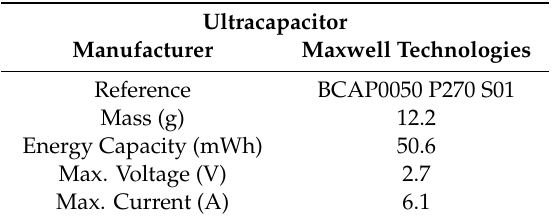
Table 2. Characteristics of the ultracapacitor used in this study.